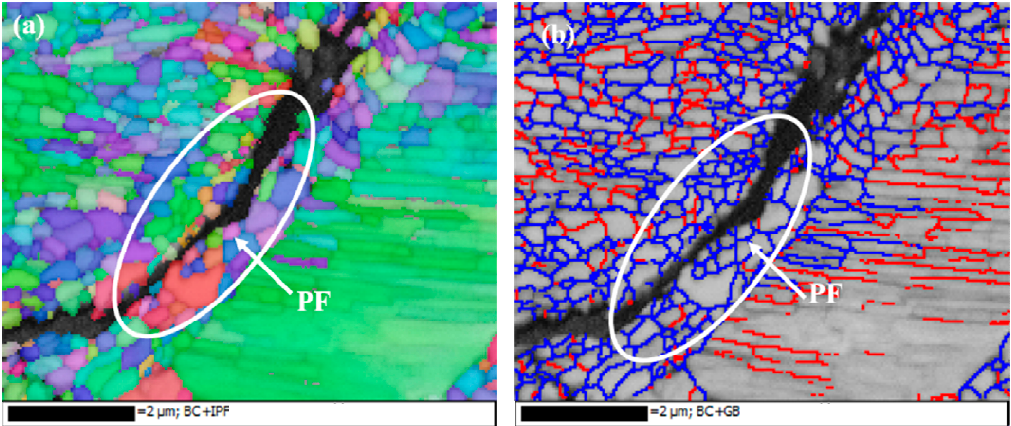
Figure 14. The EBSD micrographs of propagation of RCF cracks in proeutectoid ferrite ( a ) Inverse pole figure; ( b ) Grain misorientation figure (red lines: 2 ◦ < θ < 10 ◦ ; bule lines: θ > 10 ◦ ; “PF” is an abbreviation of proeutectoid ferrite).